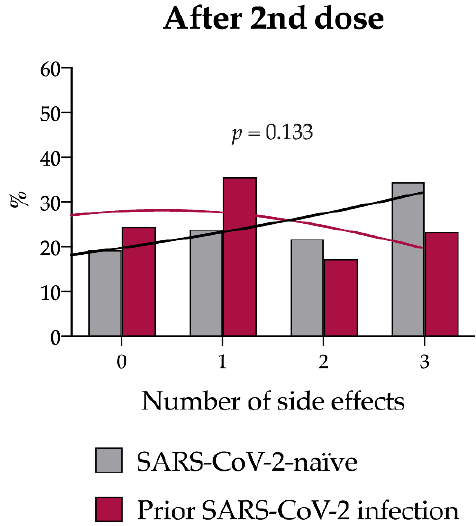
Figure 3. Number of solicited side effects after the second vaccine dose in the study population after case–control matching. Number of side effects reported for SARS-CoV-2 naïve (gray) and previously infected subjects (magenta; p = 0.133 by Chi-squared test).